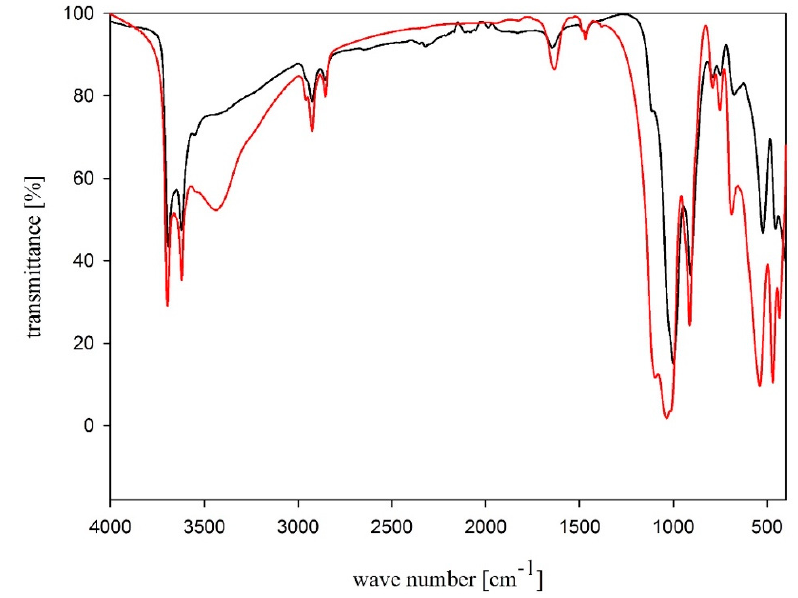
Figure 2. FTIR spectra of biohalloysite: ATR (black line), KBr (red line).